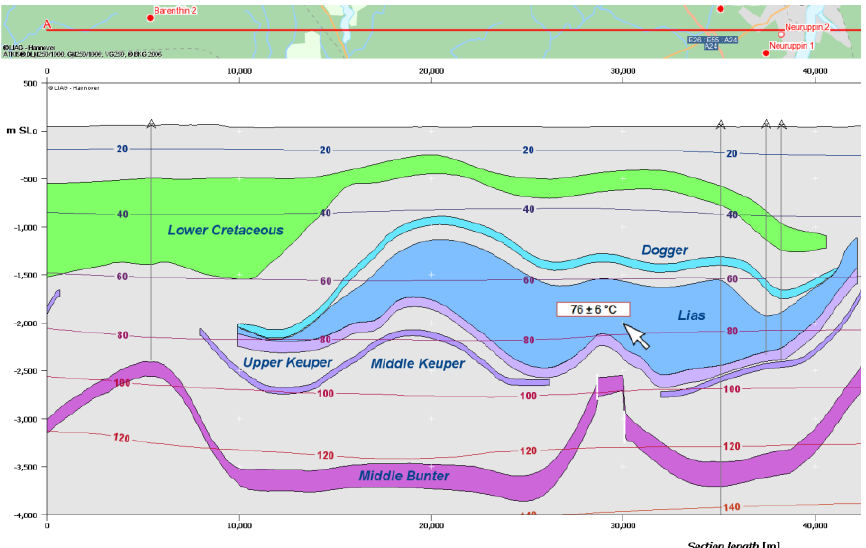
Figure 4. Screenshot of geothermal information system (GeotIS) showing an example of an interactive cross section through the eastern part of the North German Basin. Well locations (red) visible on the map strip are projected onto the cross section. Filled circles indicate wells with temperature data. A mouse-over-feature gives additional details of the well on the map strip and temperature values on the cross section. Colours of stratigraphic units, vertical exaggeration and z -axis can be adjusted by the user.